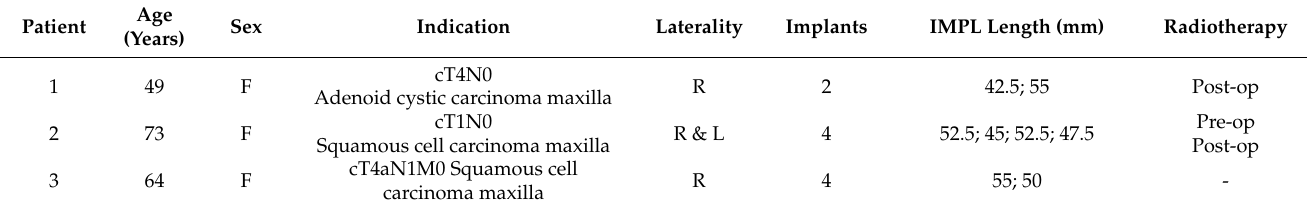
Table 1. Patient, tumor, and defect